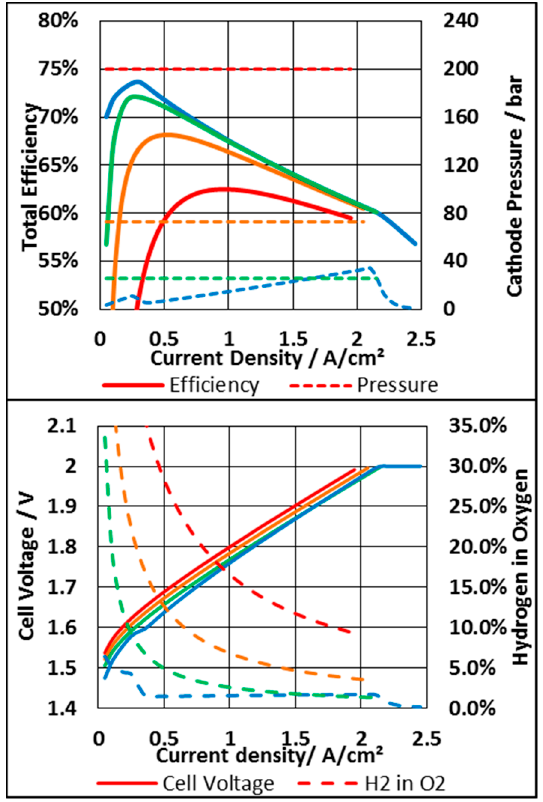
Figure 7. Top : Total efficiency and cathode pressure as a function of current density. Bottom : Polarization curve and hydrogen concentration in oxygen as a function of current density. The different pressures are colorized: 200 bar (red), 72.7 bar (orange), 26.5 bar (green), pressure optimization (blue). The curves refer to the use of an N117 membrane.